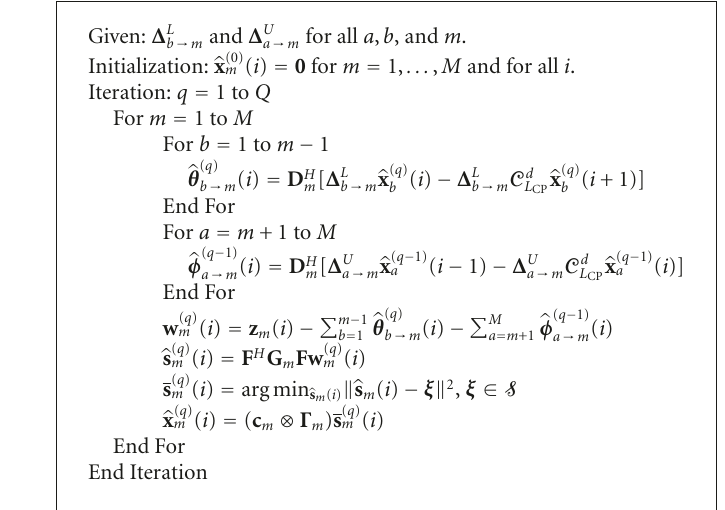
Algorithm 1: Pseudocode for detecting the signals using the iterative SIC